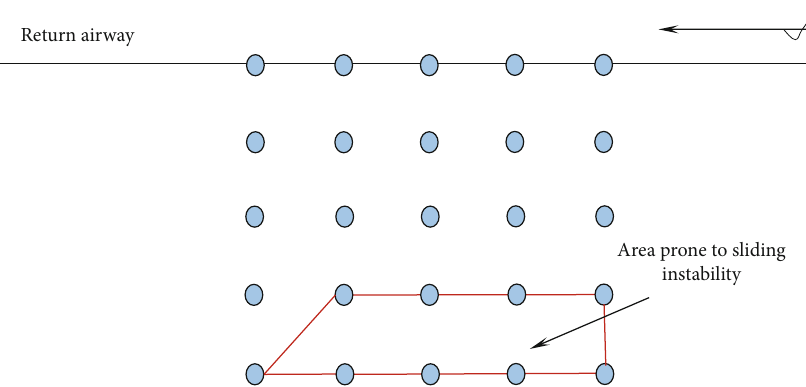
Figure 10: L = 250 m, H = 1 : 5 M of the face prone to instability